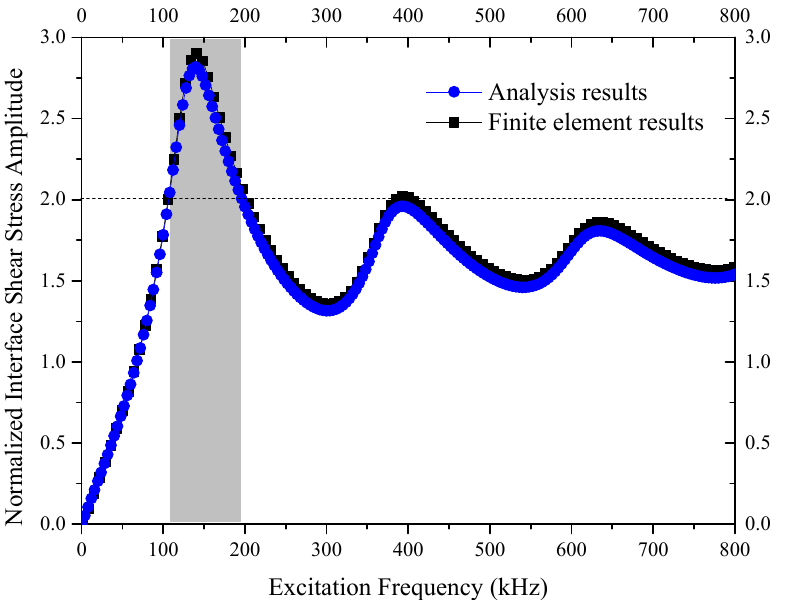
Figure 2. The analytical result and the finite element result of normalized interfacial shear stress amplitude in the excitation frequency domain as the frost coating thickness on the aluminum substrate is 5 mm, and the interfacial shear delamination interval with [ (cid:101) σ − 1 ] =